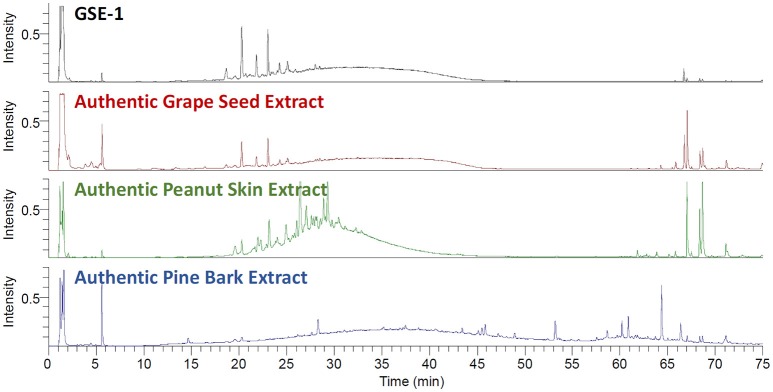
The stacked UHPLC-CAD chromatograms of the GSE-1 extract, the extracted authentic grape seed (Vitis vinifera) material, the extracted authentic peanut skin (Arachis sp.) material (green trace), and the extracted authentic pine skin (Piunus pinaster) material (blue trace). The GSE-1 and authentic grape seed extracts were in agreement. There were no indications of adulteration in the GSE-1 extract when compared to the peanut skin and pine bark traces.